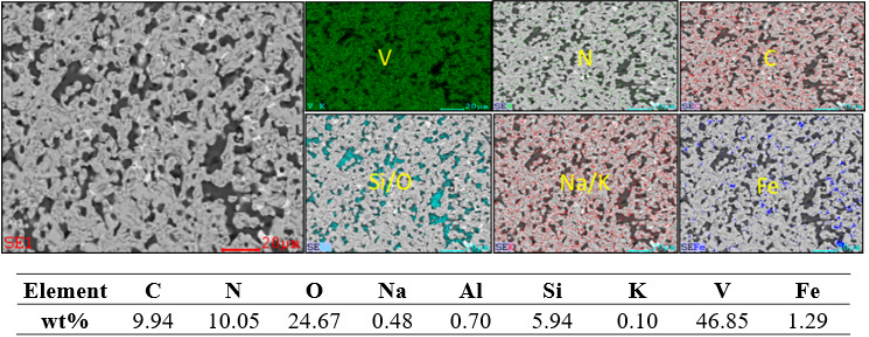
Figure 9. SEM-BSE scanning analysis results of the alloy.